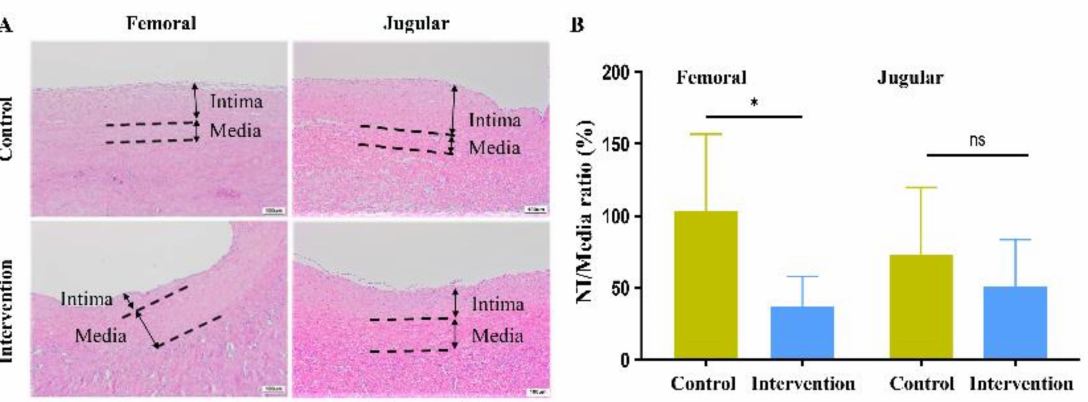
Figure 4. Inhibition of vein graft’s neointimal hyperplasia by sirolimus-embedded silk MN wrap. ( A ) Histological images with hematoxylin and eosin staining to visualize the thickening of the intima and media after sirolimus-embedded silk microneedle wrap implantation. ( B ) The neointima-to- media ratio of femoral and jugular vein grafts in the control and intervention groups (* p < 0.05; ns, p > 0.05). Scale bars indicate 100 µ